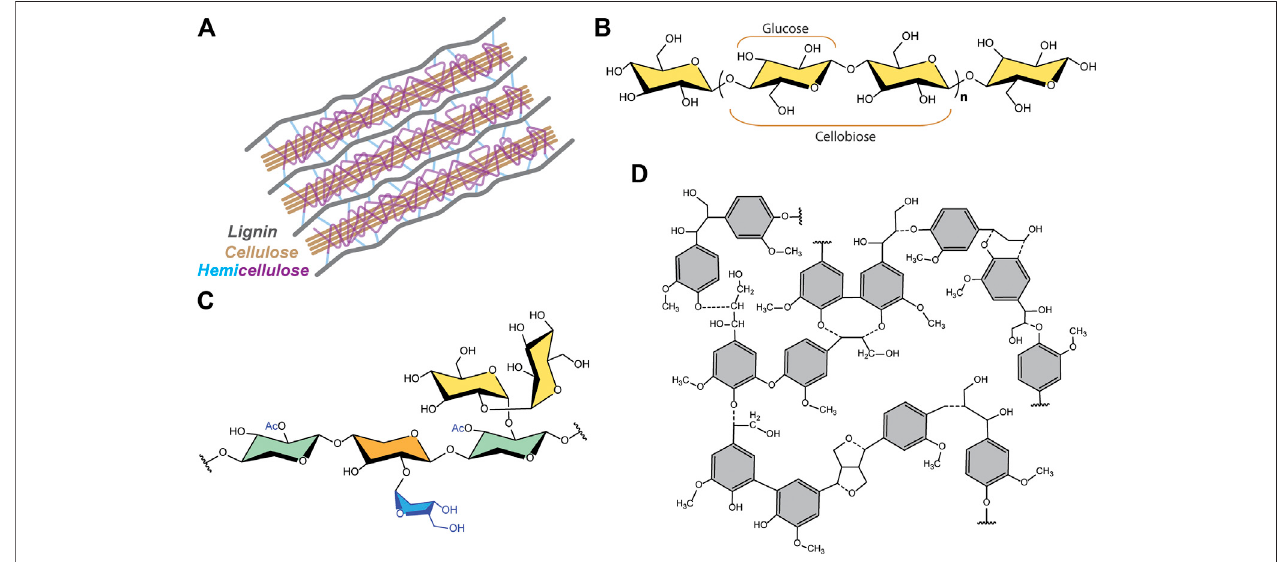
FIGURE 1 | (A) Hierarchical structure of the plant cell wall and chemical structures of its main components: (B) cellulose, (C) hemicellulose and (D) lignin. Adapted from (Heitner et al., 2010; Irmak,